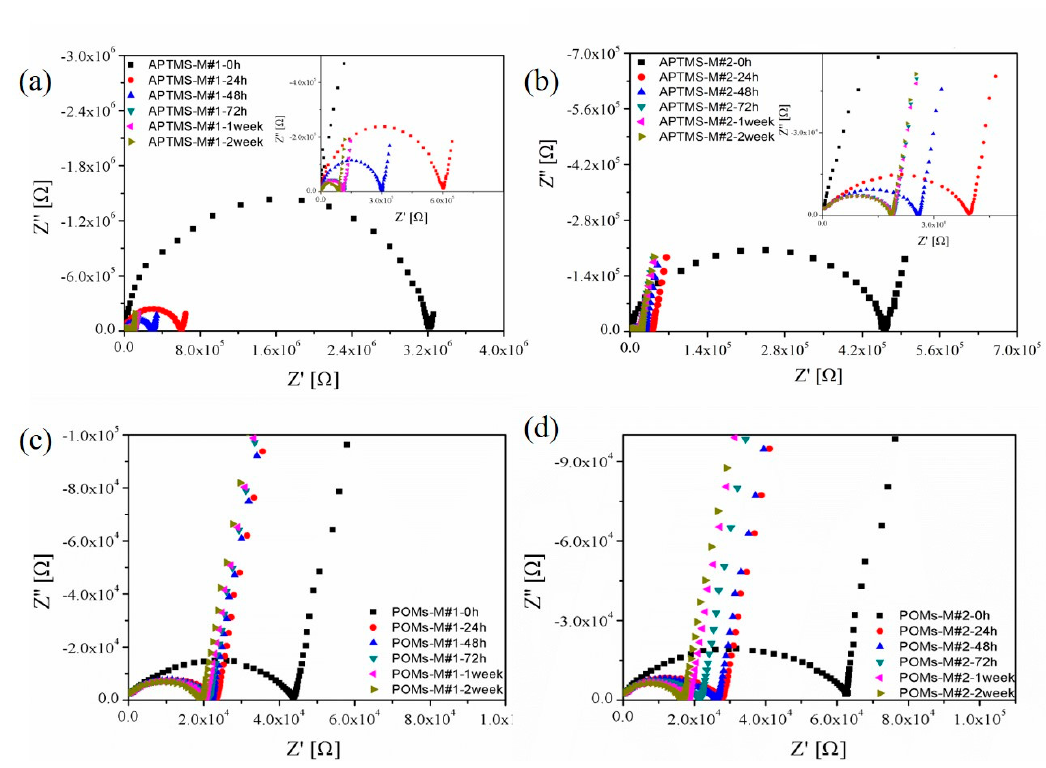
Figure 9. Nyquist plots of EIS analysis in terms of immersion time in 0.01 mol/L KCl solution: ( a ) APTMS-M#1, ( b ) APTMS-M#2, ( c ) POMs-M#1, and ( d ) POMs-M#2. Membranes 2020 , 10 , x FOR PEER REVIEW